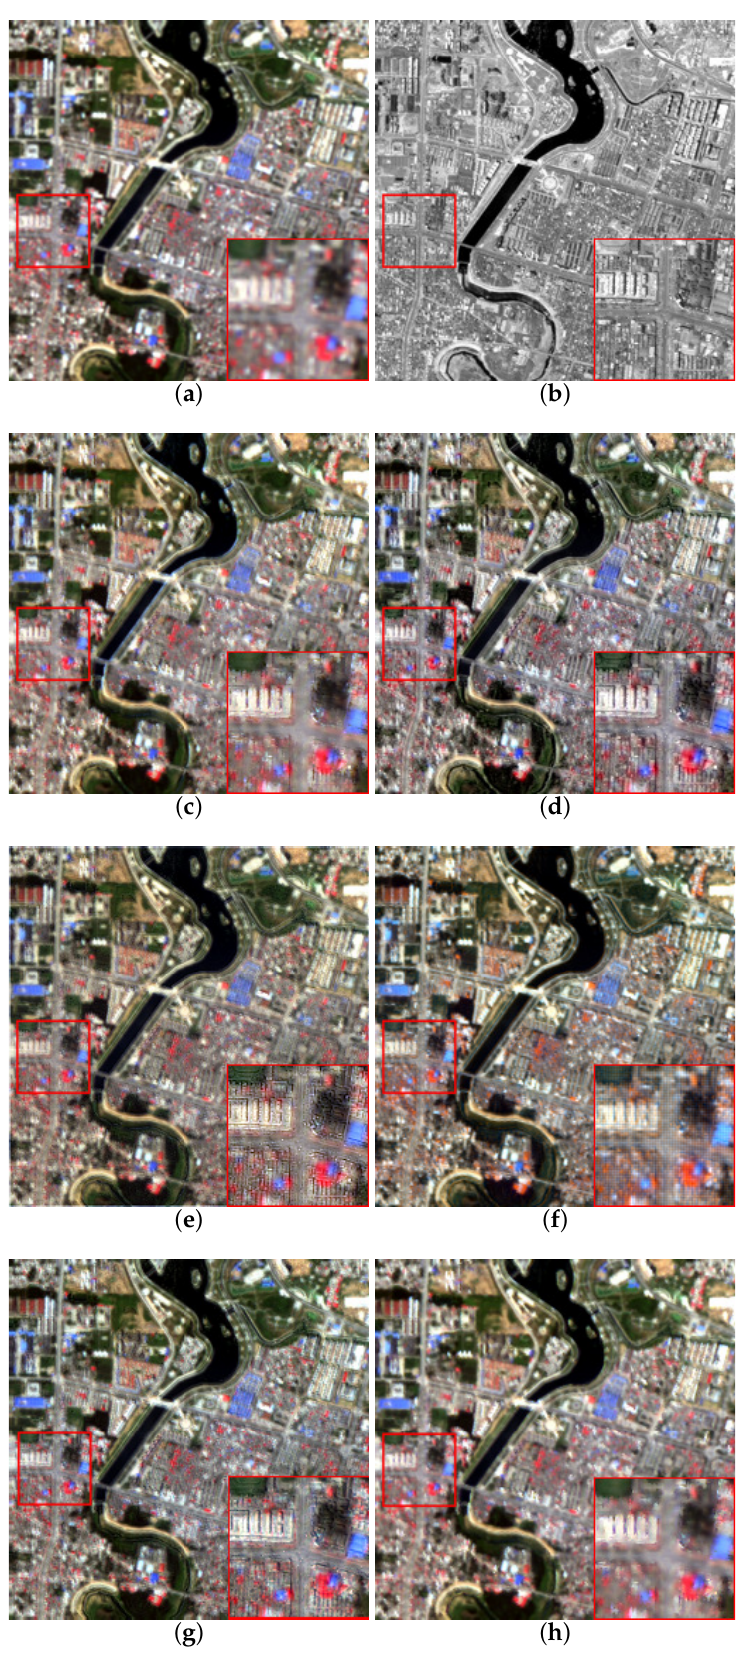
Figure 6. Fusion results of six different PS fusion methods in Gaofen-1 data fusion. ( a )